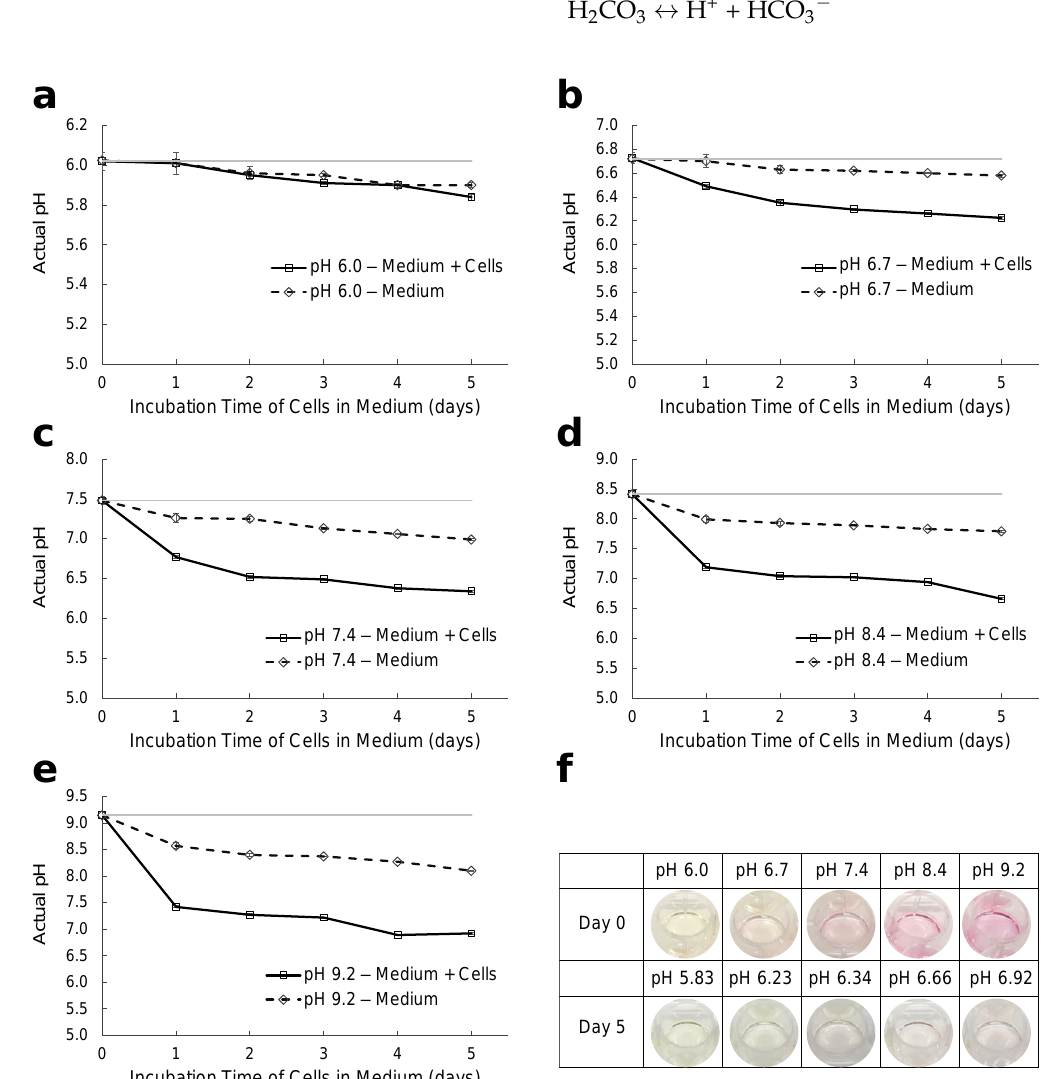
Figure 1. Extracellular pH profiles of MDA-MB-231 cells over time. MDA-MB-231 cells were seeded in a 12 well plate and they were incubated at five different pHs, ( a ) pH 6.0; ( b ) pH 6.7; ( c ) pH 7.4; ( d ) pH 8.4; and ( e ) pH 9.2 of DMEM. They were maintained at 37 °C in an incubator and pHs were measured every day. Medium only (dotted line), MDA-MB-231 cells in different pH medium (solid black line), and reference line (solid gray line). ( f ) Medium color of MDA-MB-231 cells in 12 well plates at day 0 and day 5.